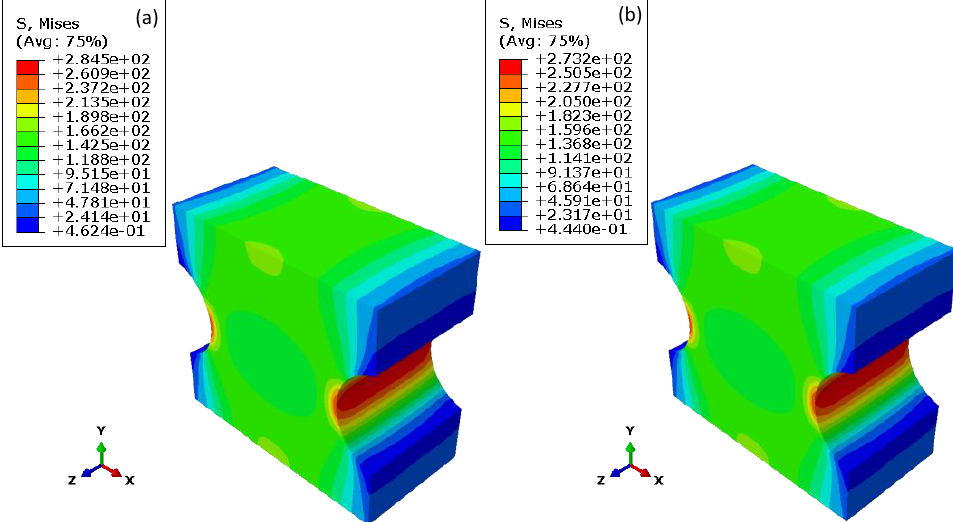
Figure 10. Isotropic elastic simulation coarse-grain ( a ) material and for the fine-grain textured material ( b ), using a Ramberg–Osgood approach.